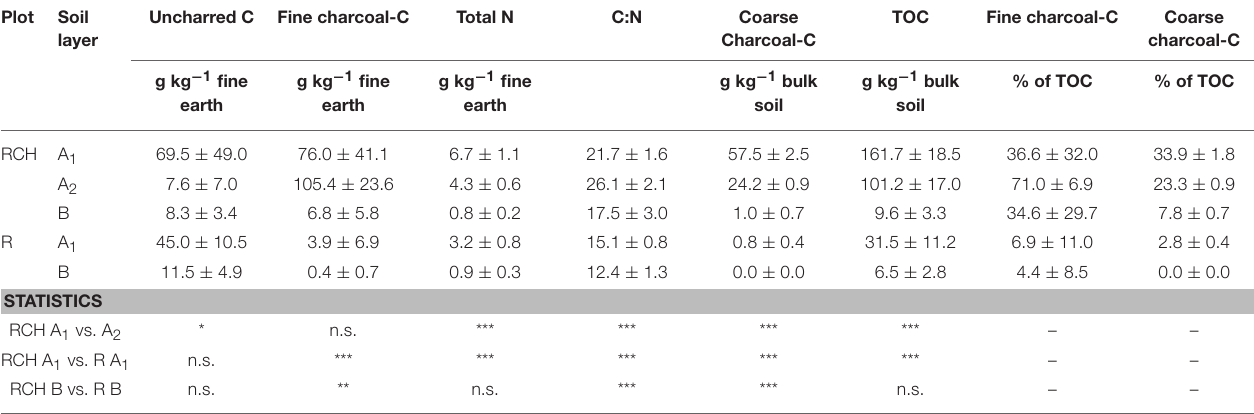
TABLE 2 | Properties of relic charcoal hearths (RCH) and reference (R) soil. Plot Soil Uncharred C Fine charcoal-C Total N C:N Coarse layer